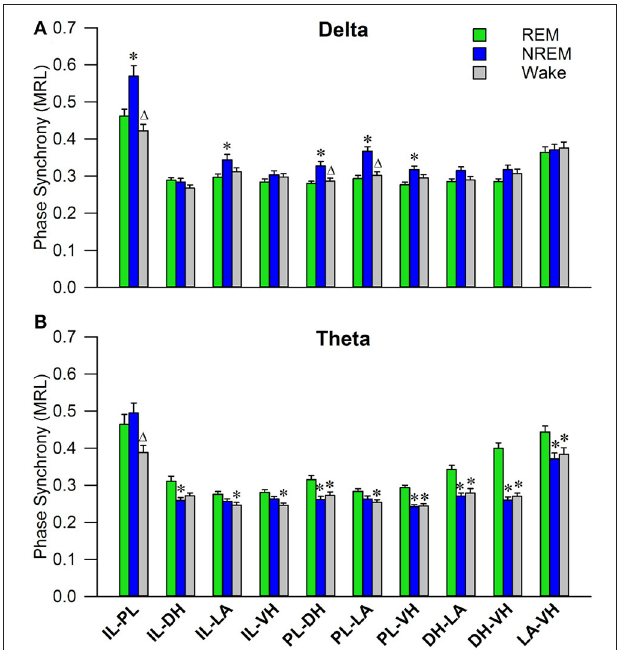
FIGURE 4 | Delta and Theta Synchrony across Vigilance States. Bar plots displaying delta (A) and theta (B) synchrony across vigilance states, where 1.0 is perfect synchrony and 0 is no synchrony. Delta rhythms appear to synchronize the PL to the DH, LA, and VH during non-REM sleep, while also synchronizing the IL with the PL and LA. Theta rhythms display increased synchrony across every regional pairing except within the cortex (IL-PL). *denotes significant difference ( p < 0.05) compared to REM, and 1 denotes significant difference ( p < 0.05) compared to non-REM. PL, pre-limbic; IL, infra-limbic; DH, dorsal hippocampus; LA, lateral amygdala; VH, ventral hippocampus.